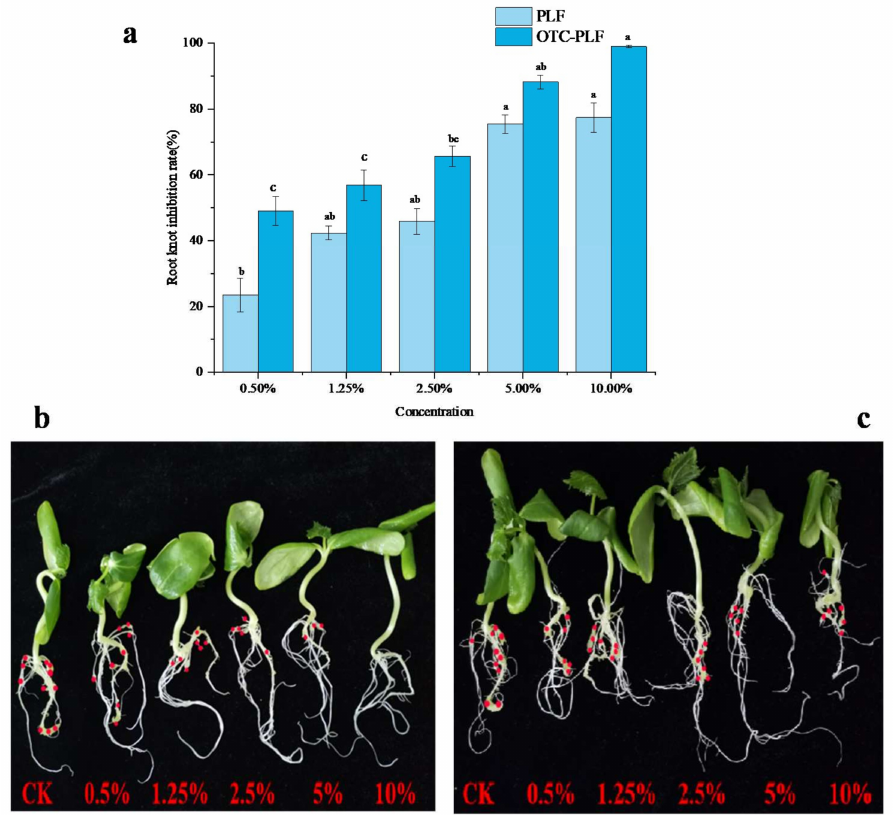
Figure 6. Effects of culture filtrates (OTC-PLF and PLF) on root-knot nematode (RKN) diseases in Pluronic gel assay. ( a ) shows the results of relative root-knot inhibition rate. ( b ) shows the symptoms of plant roots infested with M. incognita treated with OTC-PLF. ( c ) was the symptom of plant roots infested with M. incognita treated with PLF. OTC-PLF represents the culture filtrates of Purpureocillium lilacinum combined with by 6-oxychitin. PLF represents the culture filtrates of Purpureocillium lilacinum . Different letters represent significant differences ( p < 0.05) according to Duncan’s